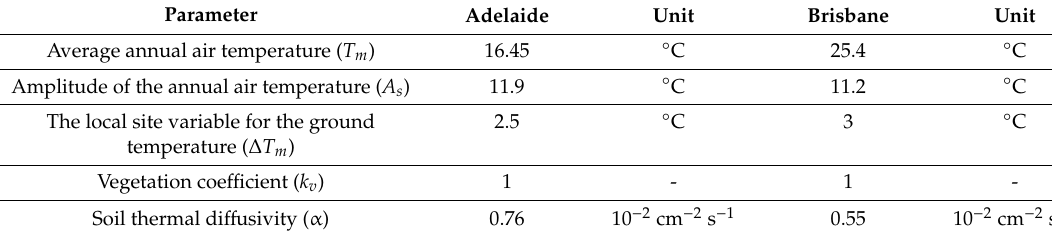
Table 2. The parameters reference used to estimate the soil temperature.